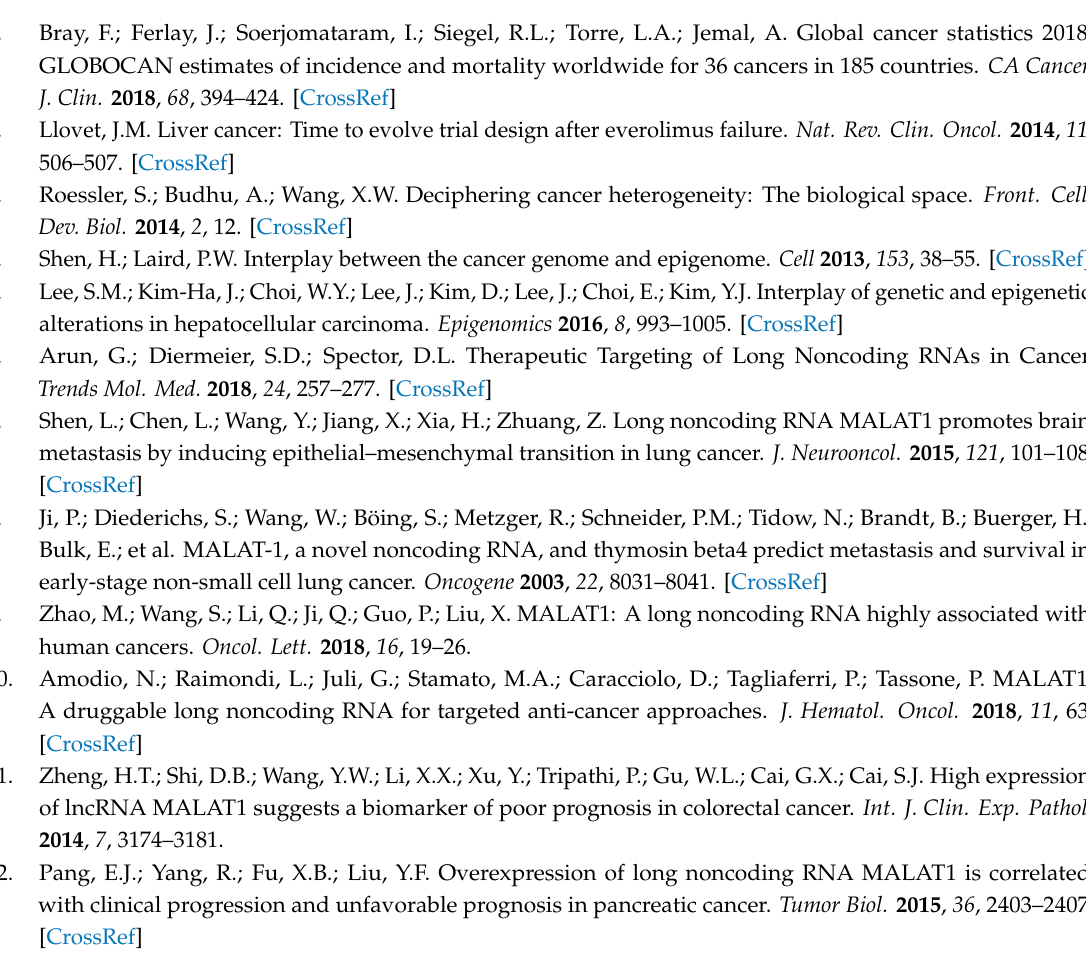
Table S1: Odds ratio (OR) and 95% confidence interval (CI) of clinical status and MALAT1 genotypic frequencies in 394 hepatocellular carcinoma patients, Table S2: Distribution frequency of the clinical status and for MALAT1 SNPs frequencies in hepatocellular carcinoma patients with stratified by gender, Table S3: Distribution frequency of the clinical status and for MALAT1 SNPs frequencies in hepatocellular carcinoma patients with stratified by smoking status, Table S4: Association of MALAT1 genotypic frequencies with hepatocellular carcinoma laboratory findings, Table S5: Odds ratio (OR) and 95% confidence interval (CI) of clinical status and MALAT1 genotypic frequencies in hepatocellular carcinoma patients with hepatitis B virus infection ( n = 167), Table S6: Odds ratio (OR) and 95% confidence interval (CI) of clinical status and MALAT1 genotypic frequencies in hepatocellular carcinoma patients with hepatitis C virus infection ( n =